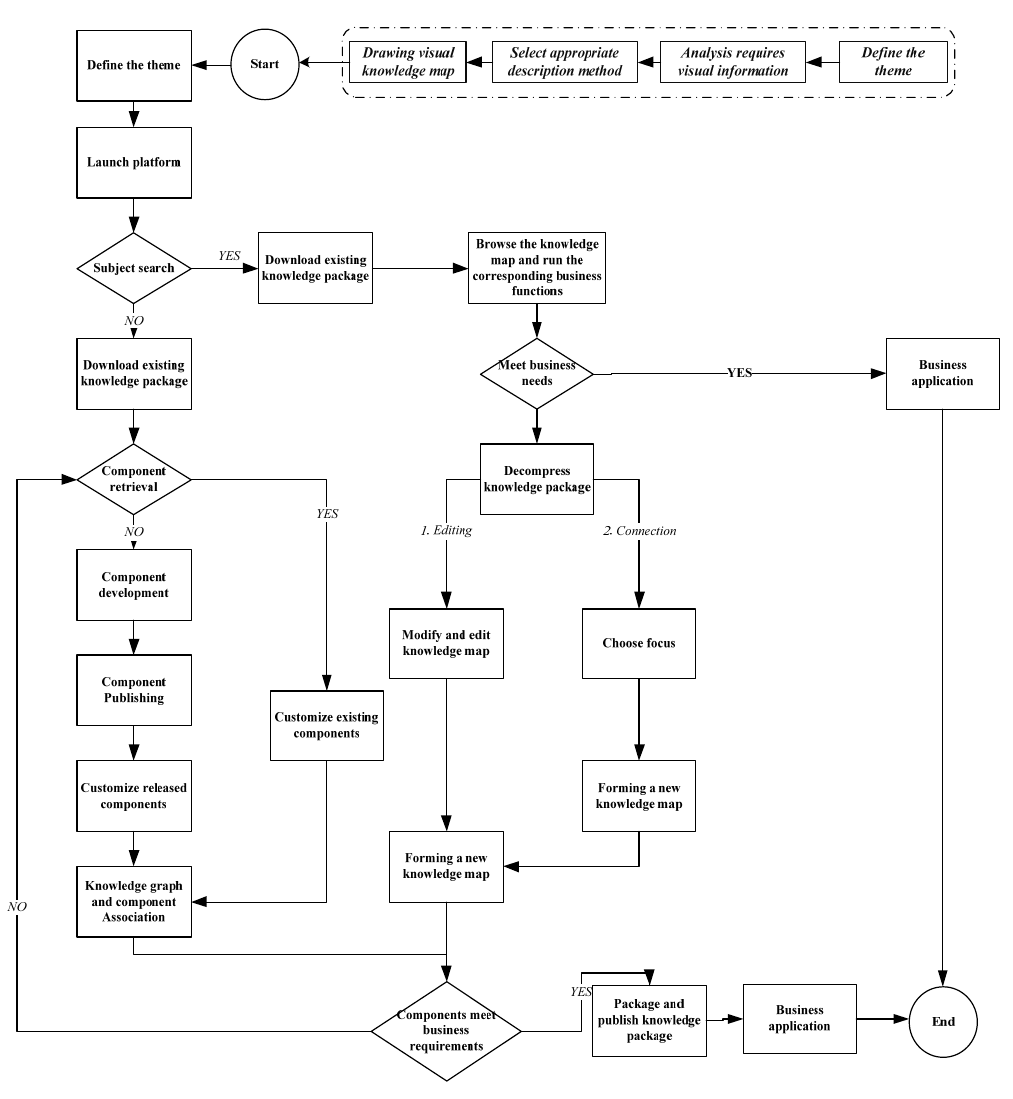
Figure 9. Visual description process.